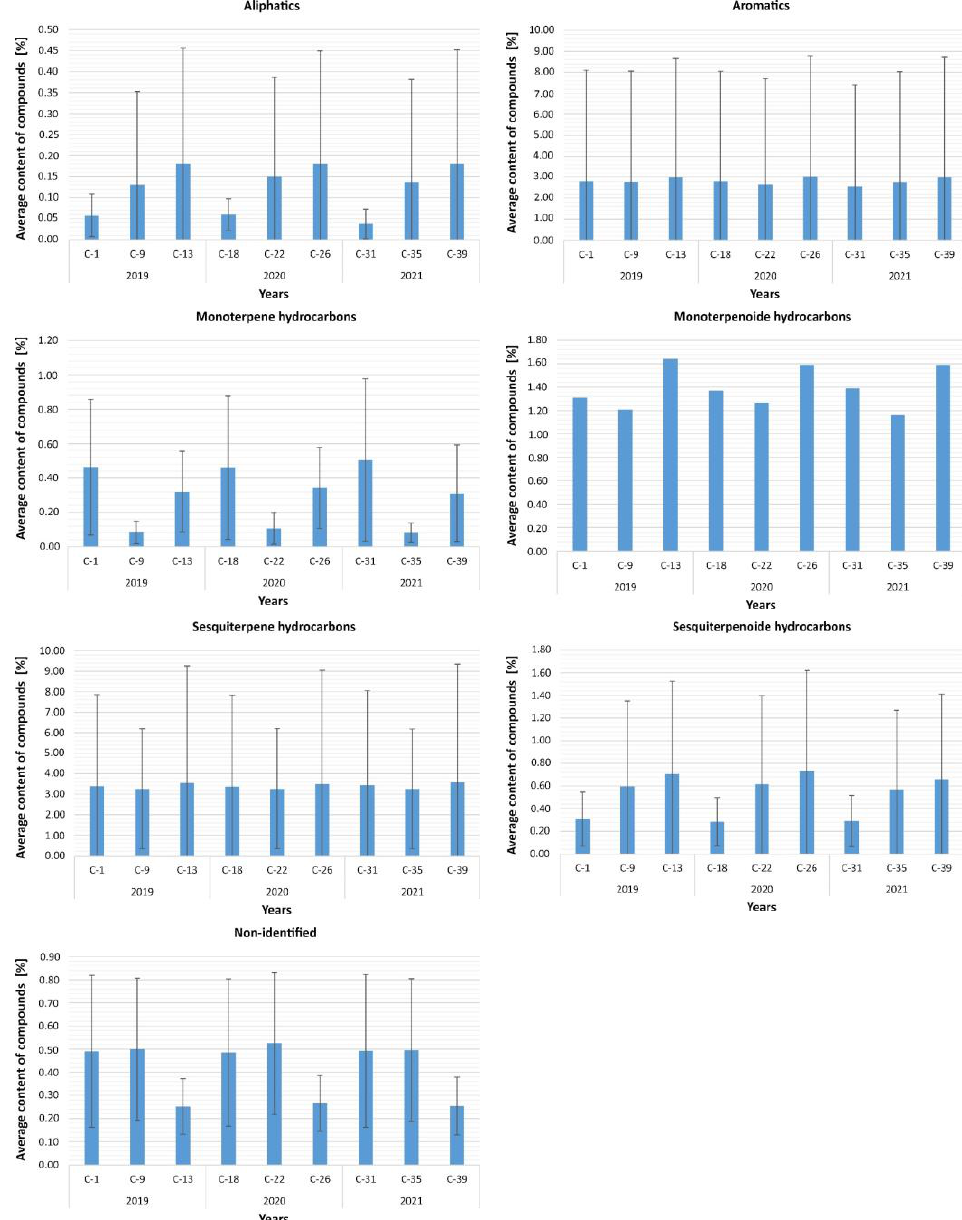
Figure 4. Average content of volatile organic compounds depending on the season.